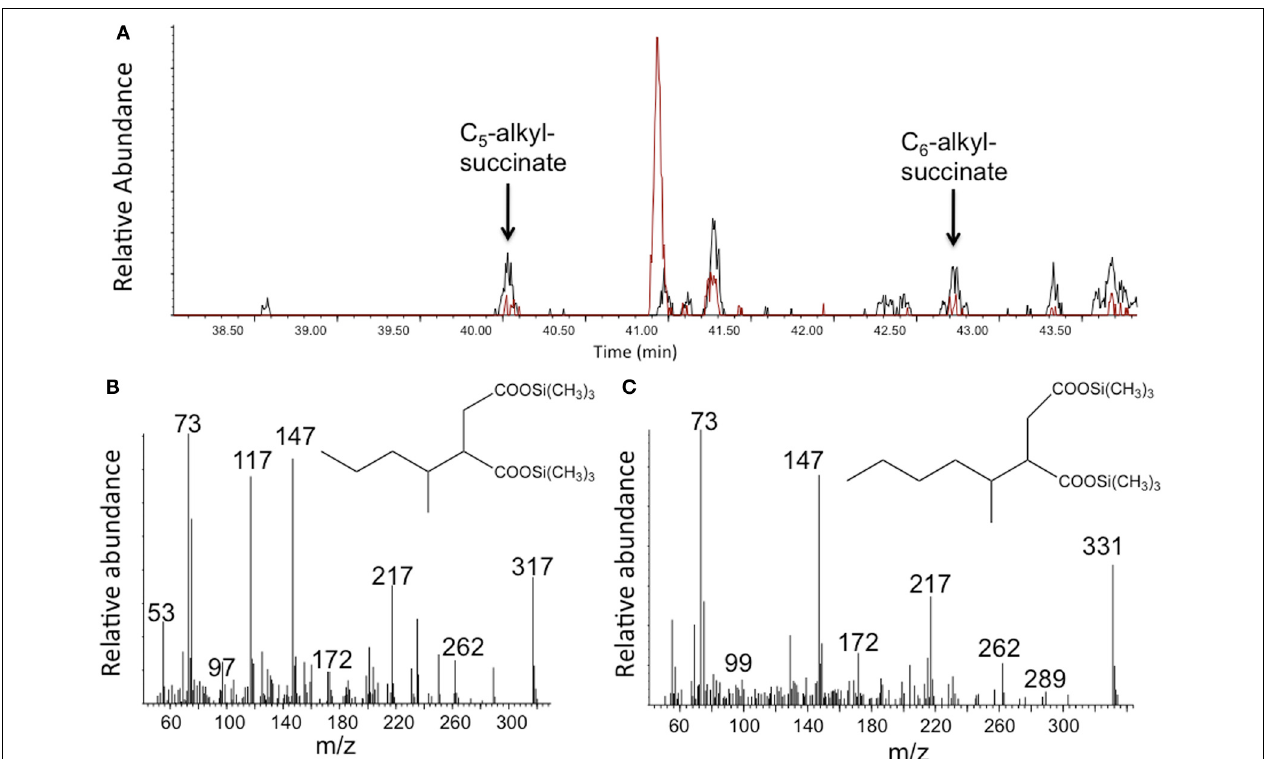
FIGURE 2 | Detection of putative alkylsuccinates in methanogenic crude oil-amended incubations. (A) A portion of a GC total ion chromatogram showing larger peaks detected in oil-amended culture extracts (black) relative